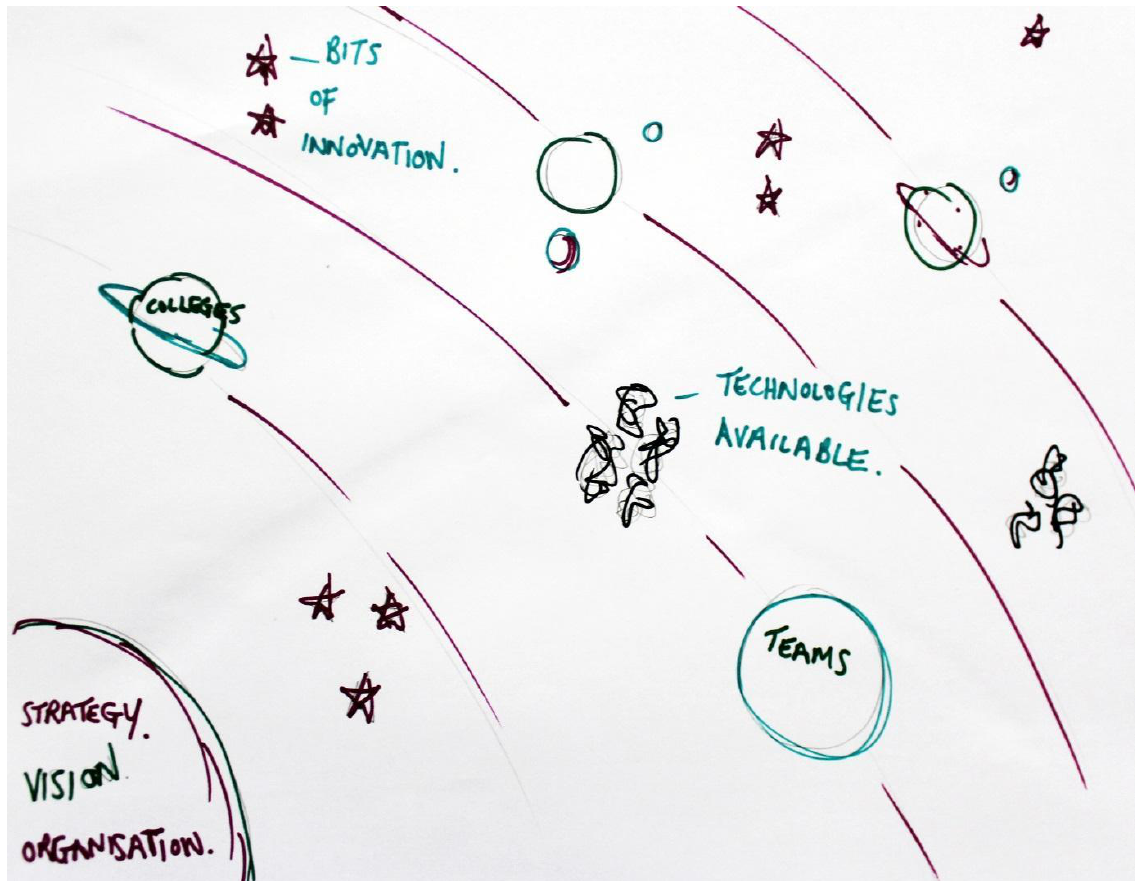
Figure 2: Institutional Representation (Value